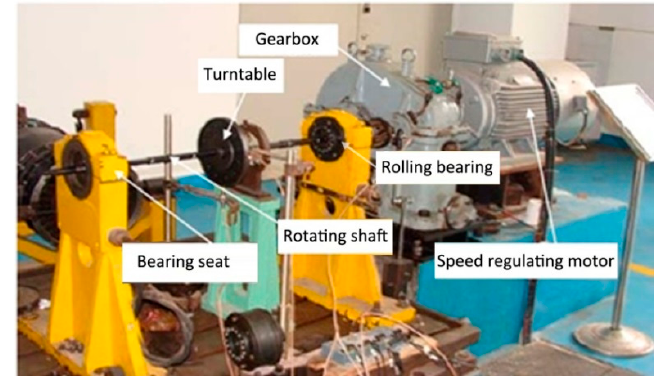
Figure 21. Rotor-bearing experimental system.